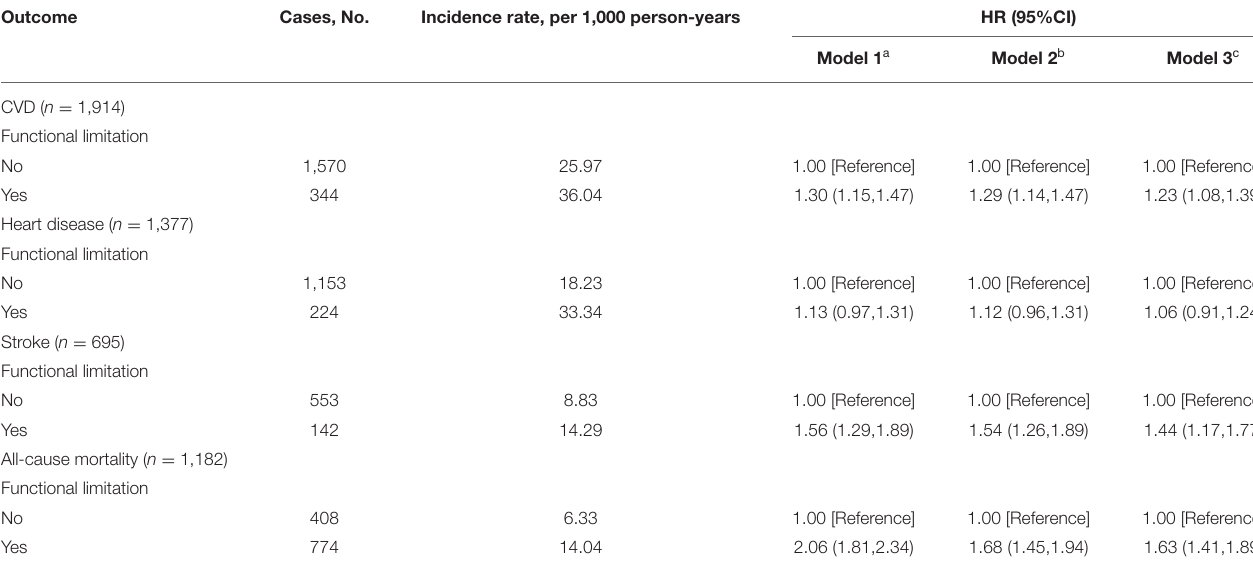
TABLE 2 | Incidence rate of CVD and all-cause mortality according to functional status. Outcome Cases, No.